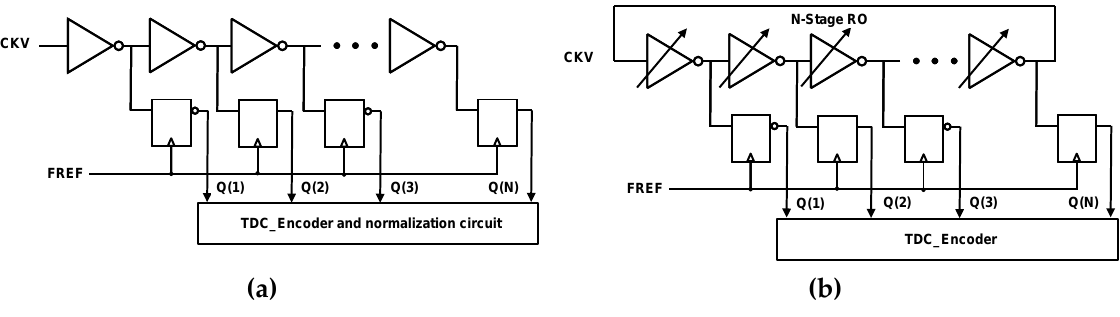
Figure 4. ( a ) Classical Flash TDC; ( b ) Embedded